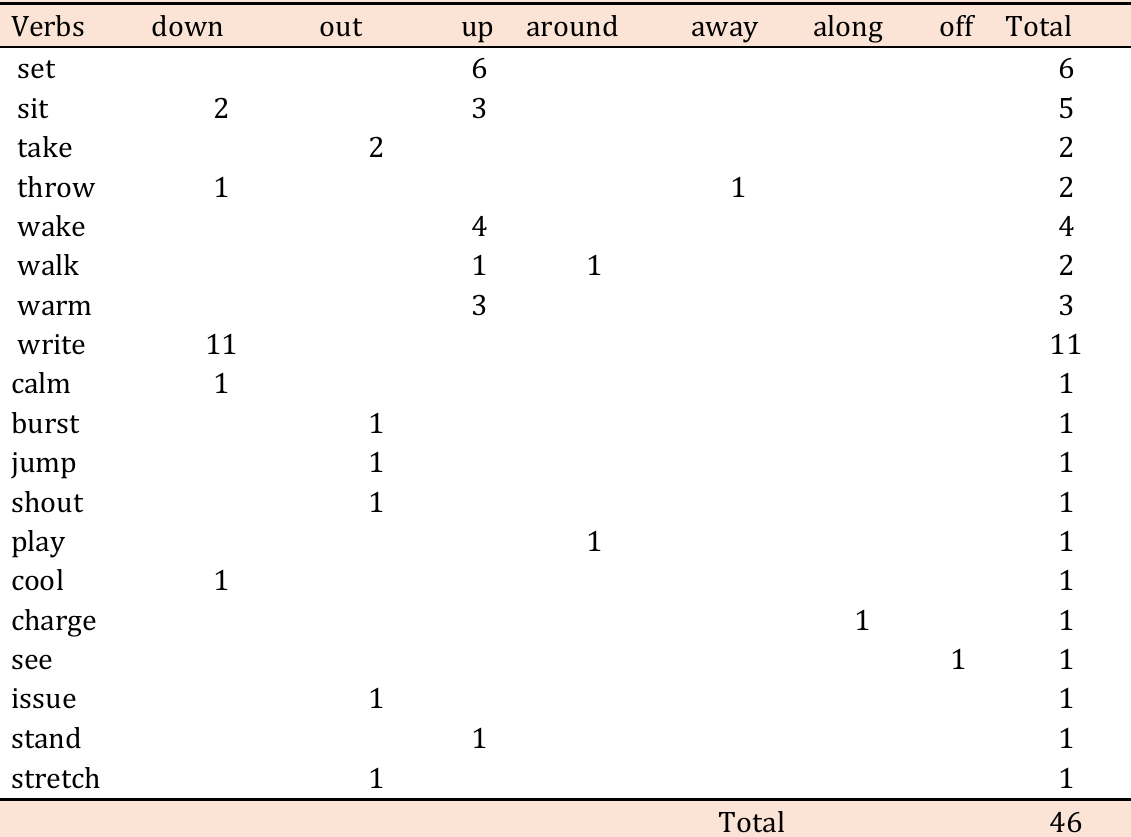
Table 2. The frequency distribution of the Phrasal Verbs and related particles in the textbook